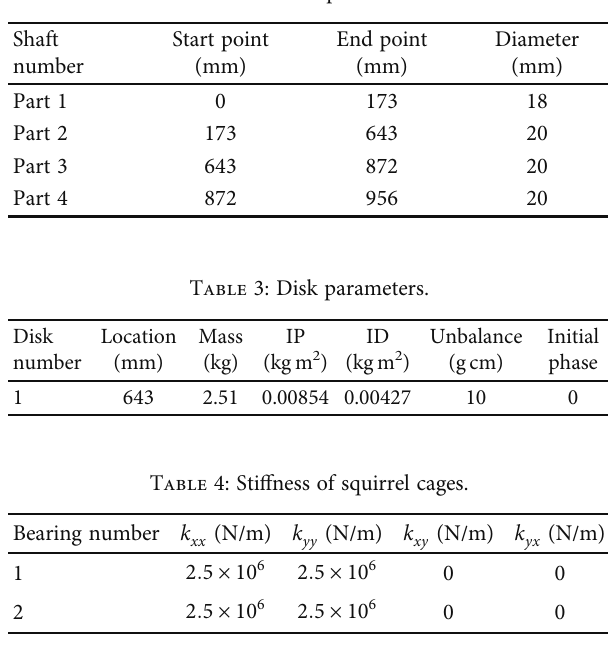
Figure 6: Dynamic model of the SFD-rotor system. Table 2: Shaft parameters.